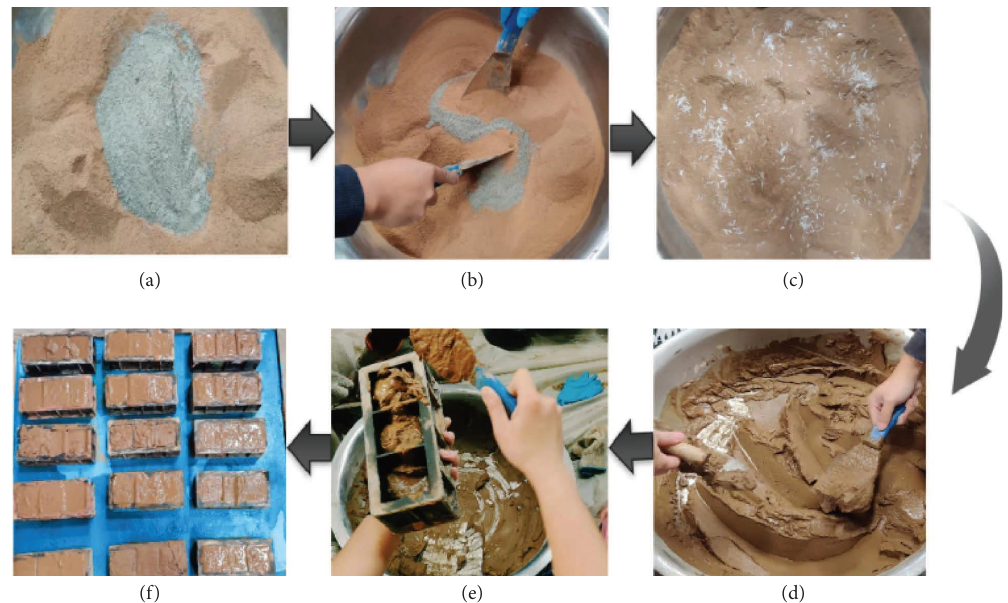
Figure 4: Preparation process of specimens is (a) mixing cement and soil; (b) dry mixing; (c) incorporation of fbers; (d) mixing with water; (e) molding; (f) vibration